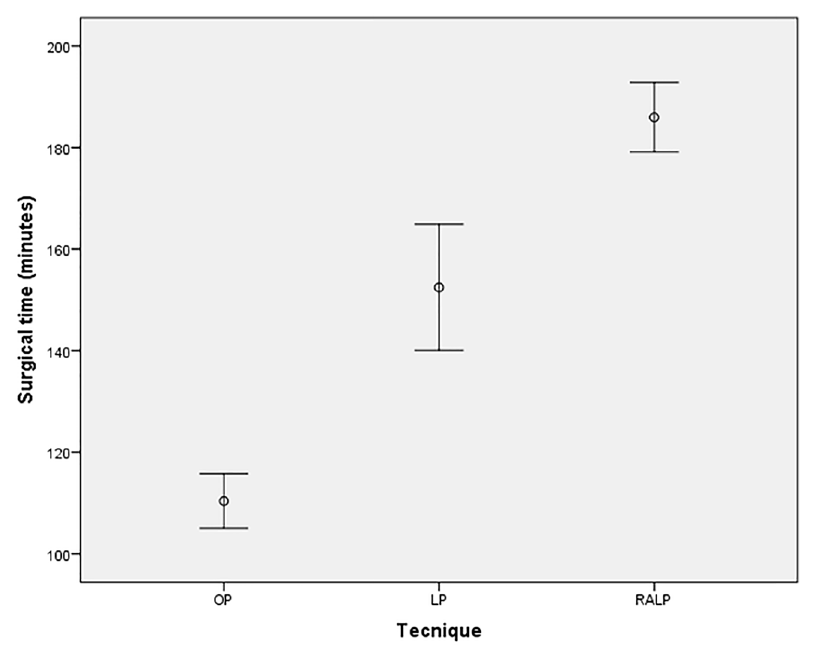
Figure 1B. Hospitay